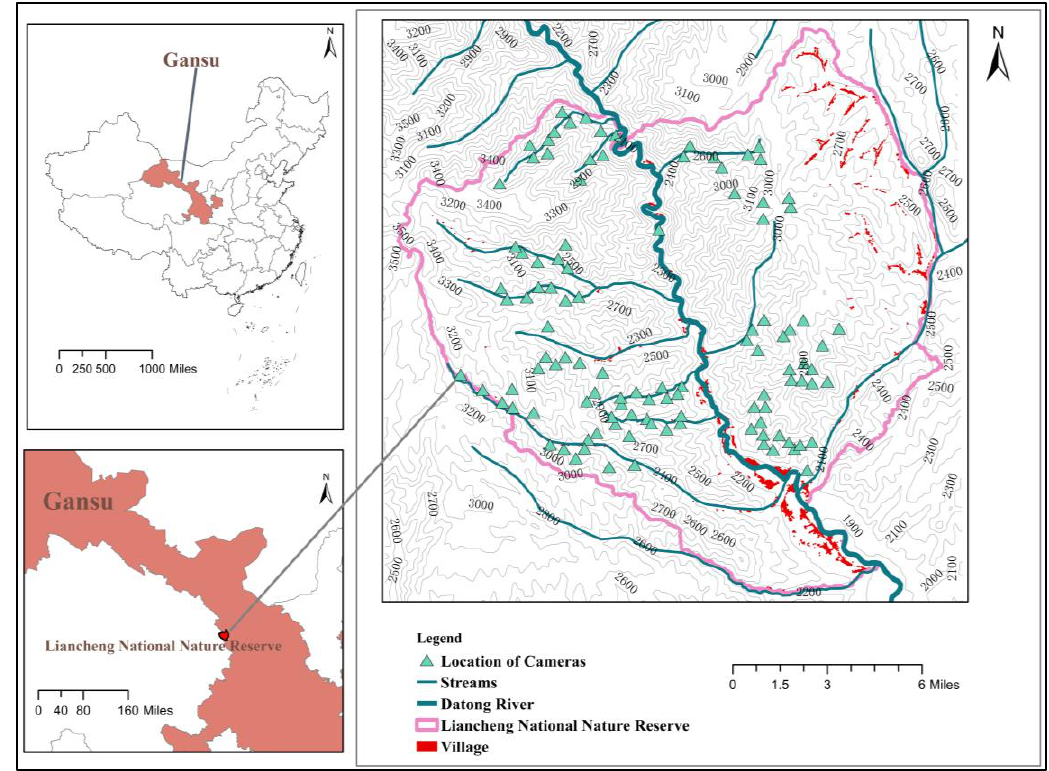
Figure 1. Location of LNNR and camera traps.